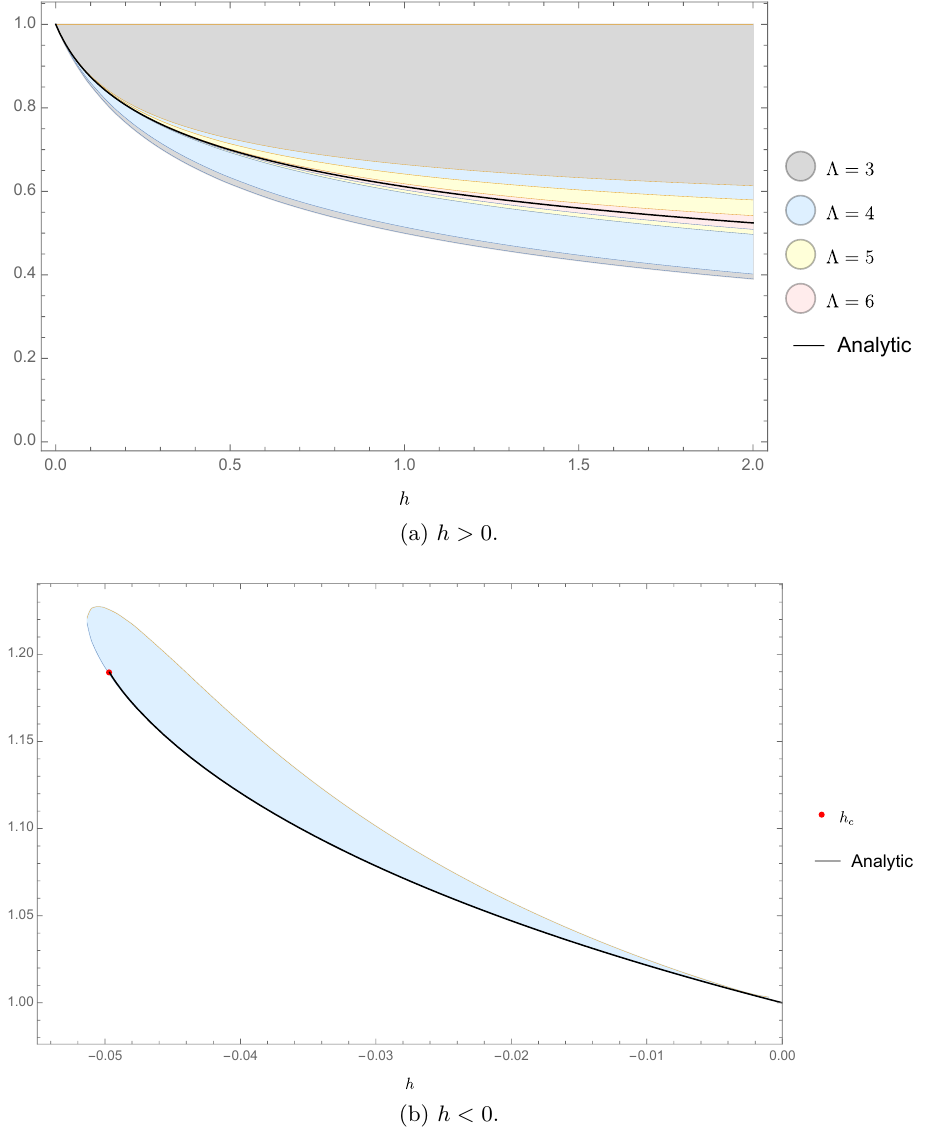
Figure 6 . Comparison of the numerical bootstrap results with the exact analytic solution of the model (5.1) with g = 0 . The lower plot is for Λ = 8